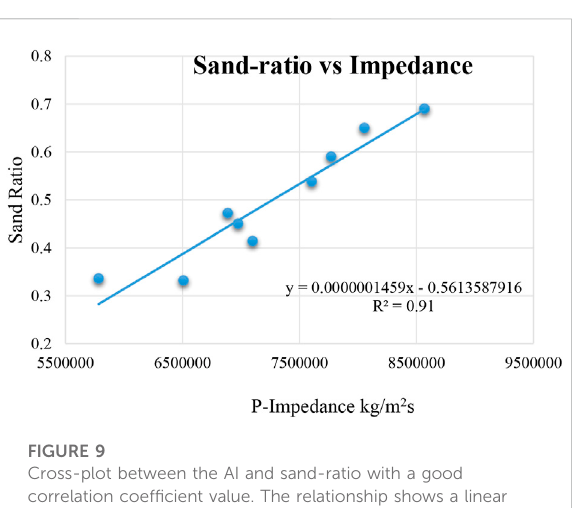
FIGURE 9 Cross-plot between the AI and sand-ratio with a good correlation coef fi cient value. The relationship shows a linear relationshipwith apositive slope.Thenine pointsshowstheAIand sand-ratio values of nine studied wells that lie within the targeted T9c-T9d horizons.